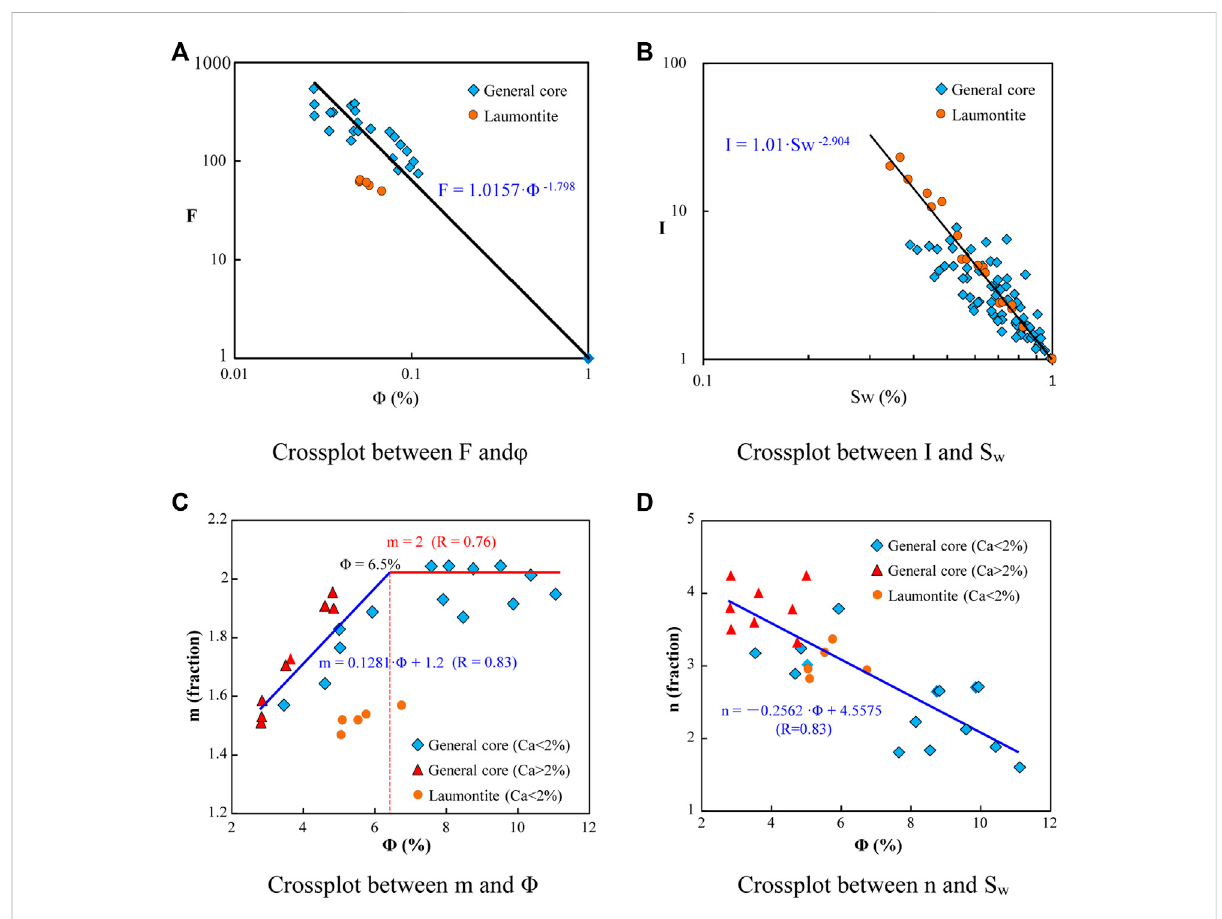
FIGURE 16 Rock-electroparameters. (A) CrossplotbetweenFand φ . (B) CrossplotbetweenIandS w . (C) Crossplotbetweenmand Φ . (D) Crossplotbetween n and S w